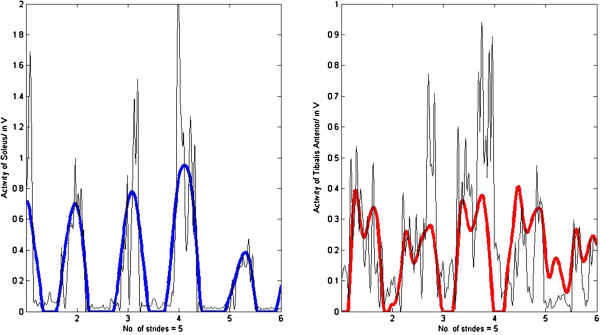
Rave = 0.63. Muscle activation of the soleus (RSOL = 0.79) and the tibialis anterior (RTA = 0.46) of subject #1 performing silly walks with insole forces and hip angles as inputs (bold lines represent the output from the SPG model and thin lines the experimental EMG data).